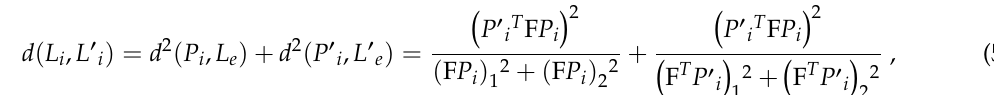
Figure 8. Average number of line segments on the East Lake and near Wuhan Yangtze River Bridge; the blue and purple respectively correspond to the water and non-water area.